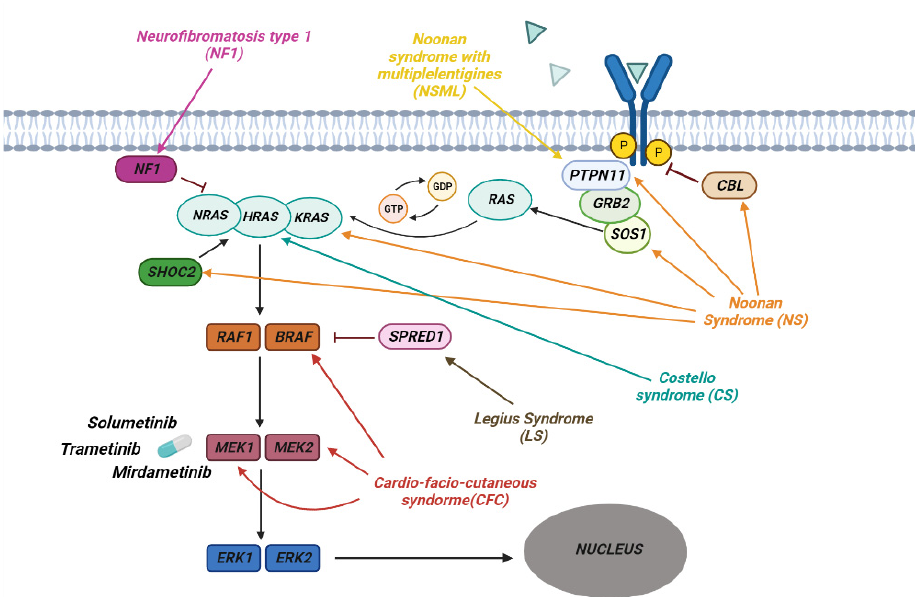
Figure 2. The pathway of RAS/MAPK in RASopathies. The figure shows how the various genes of the Ras/MAPK pathway are involved in the development of the different syndromes associated with RASopathies. Shown are some of the MERK1/2 kinase inhibitors used to treat RASopathies, some of which are FDA-approved.